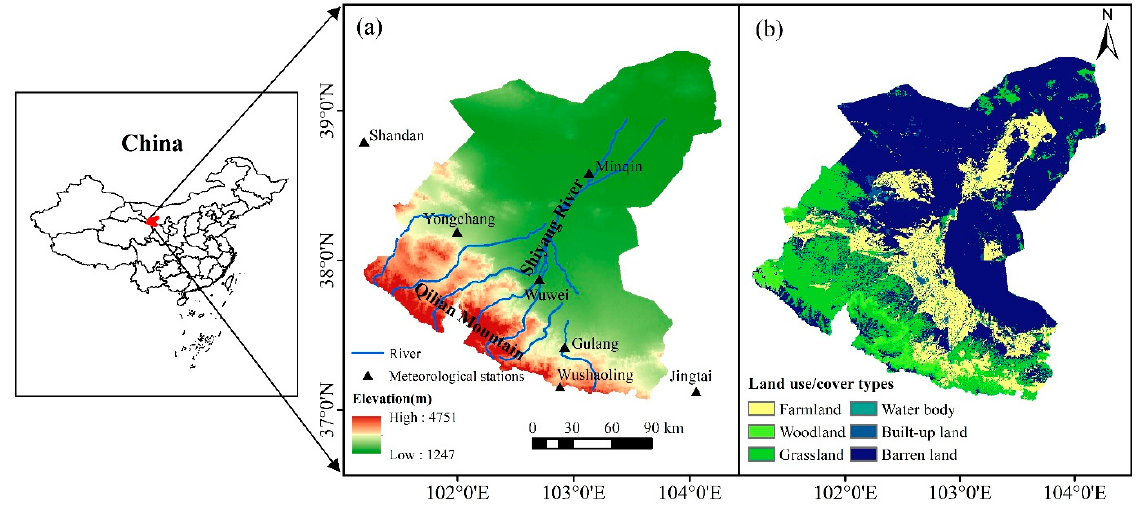
Figure 1. Map of the study area. ( a ) Location of Shiyang River Basin in northwest China and locations of meteorological stations; ( b ) land use/land cover map of the study area in 2020.